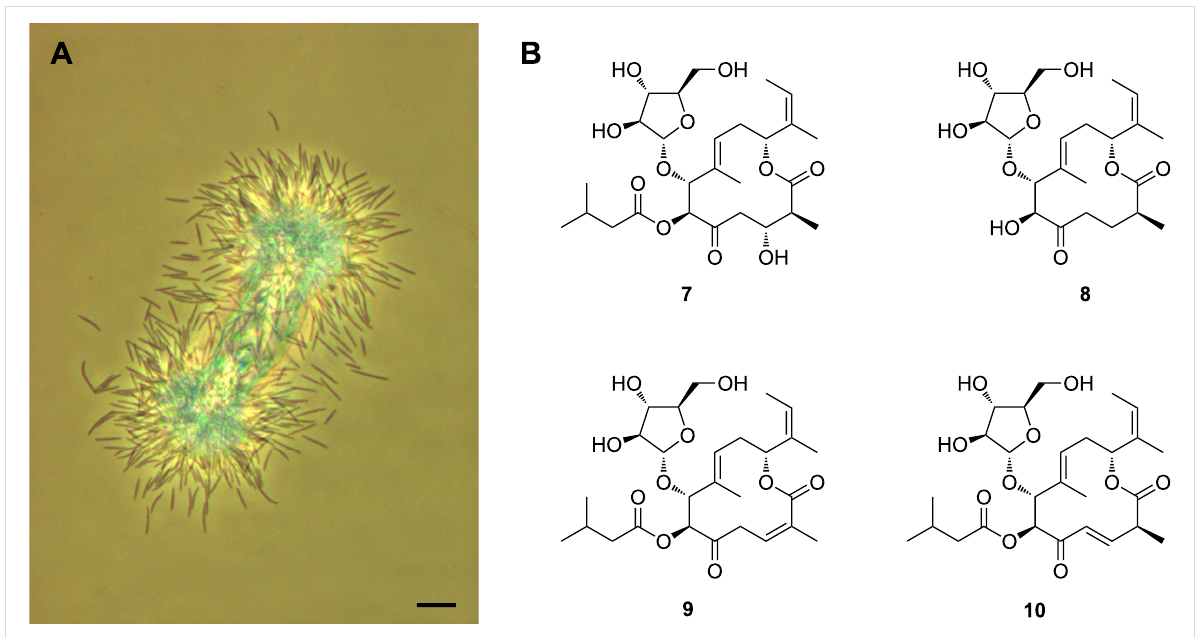
Figure 2: Vegetative cells of P. fallax HKI 727 under a phase-contrast microscope (K. Martin, unpublished). Bar is 10 μ m (A). Structures of gulmirecin A ( 7 ), gulmirecin B ( 8 ), disciformycin A ( 9 ), and disciformycin B ( 10 ) (B).